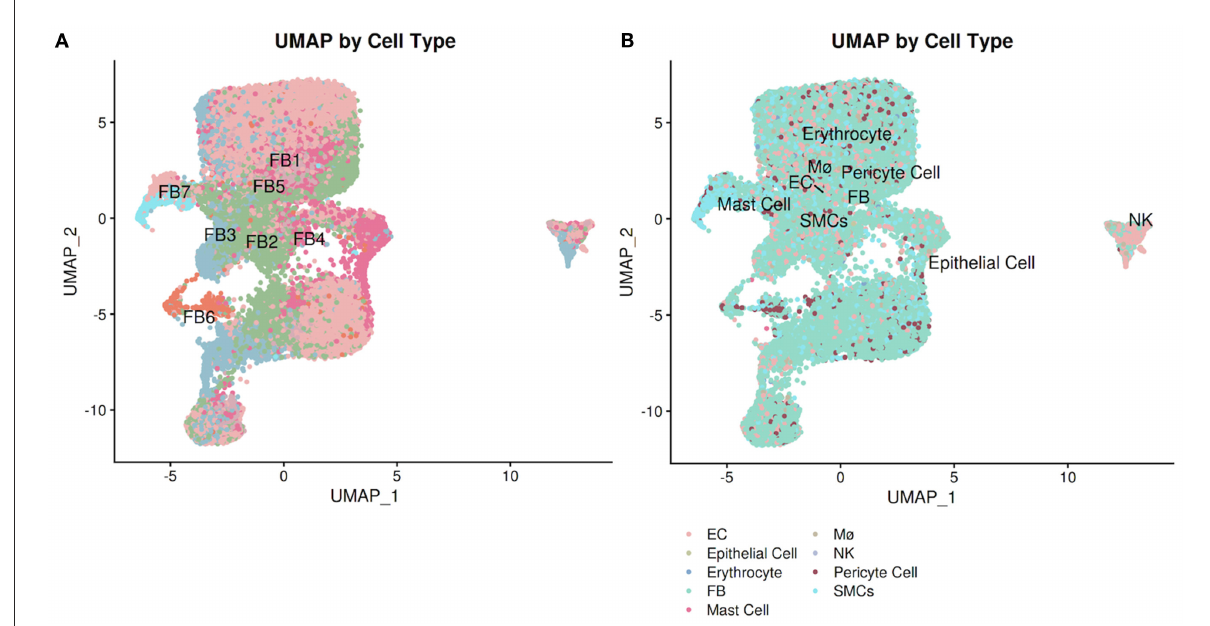
FIGURE4 Annotation explorer page facilitates cell-level annotation comparison. Users can compare pre-computed cell identity annotations as well as author-provided labels (when available). Using the Litvinukova et al. dataset, we demonstrate the difference between the annotation from the